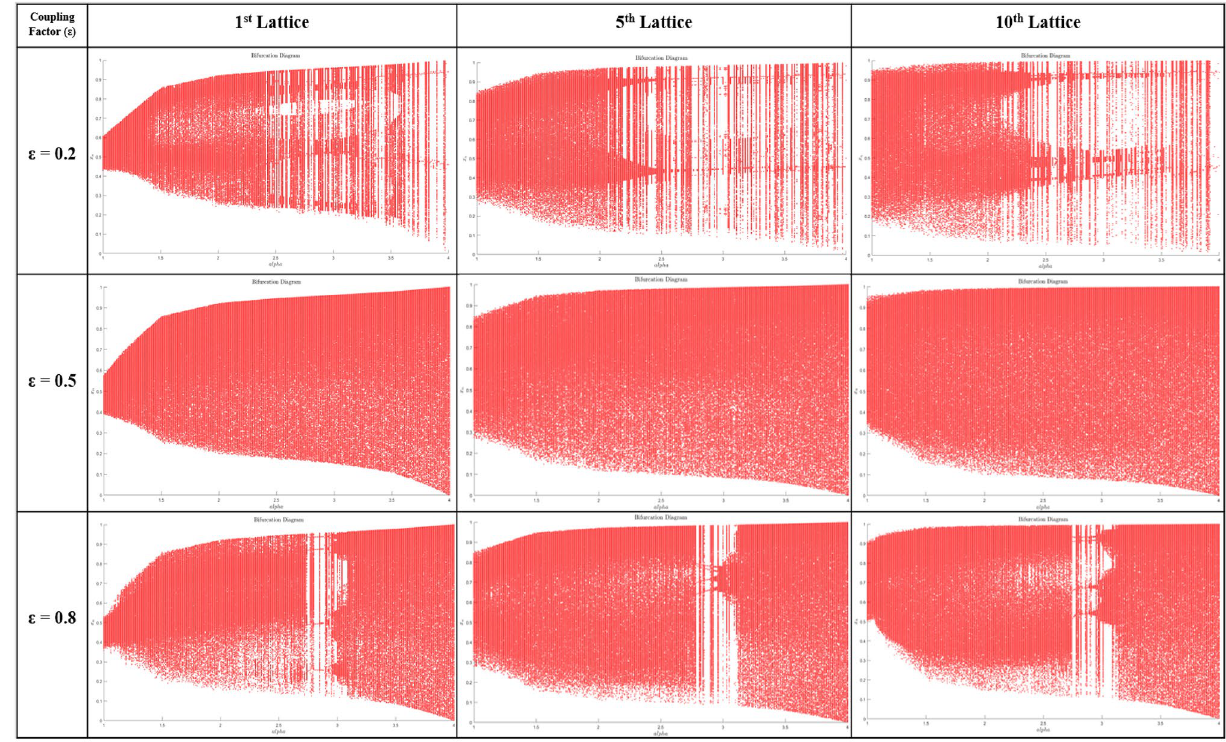
Fig. 9 Shows the bifurcation diagrams for CML system with 10 lattice points for increasing 𝜖 values and different lattice